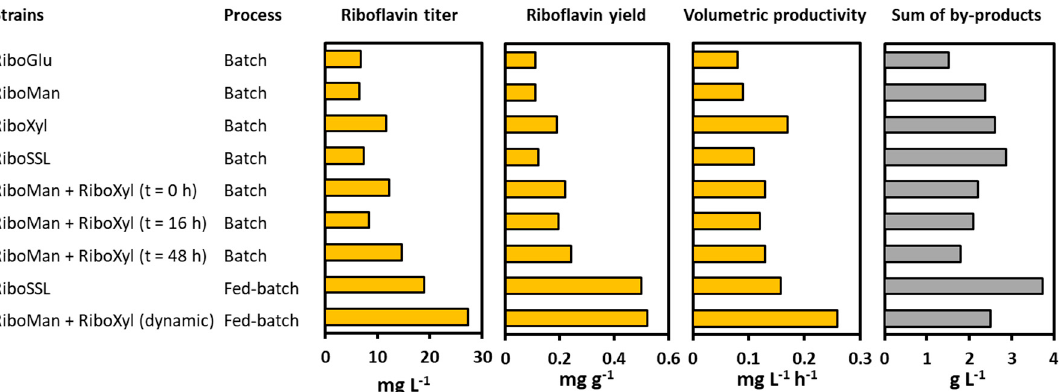
Figure 9. Production data comparison when using synSSL as the carbon source during fermentations in bioreactors. Data is depicted as follows: strain or strains used in the process, type of process performed, final riboflavin titer (mg L − 1 ), riboflavin yield (g g − 1 ), riboflavin volumetric productivity (g L − 1 h − 1 ), and total by-products accumulated (g L − 1 ). The time point for the inoculation of RiboXyl is indicated in parenthesis.